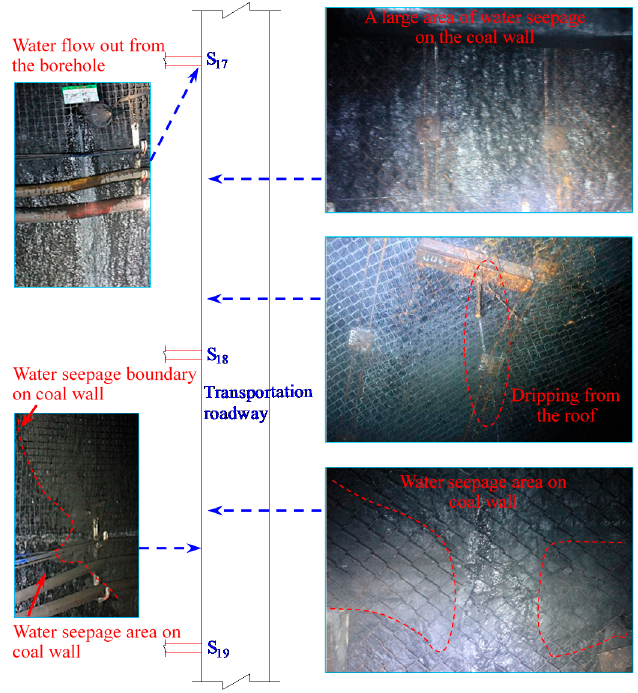
Figure 10. Water-seepage phenomenon during hydraulic fracturing of S 18 .